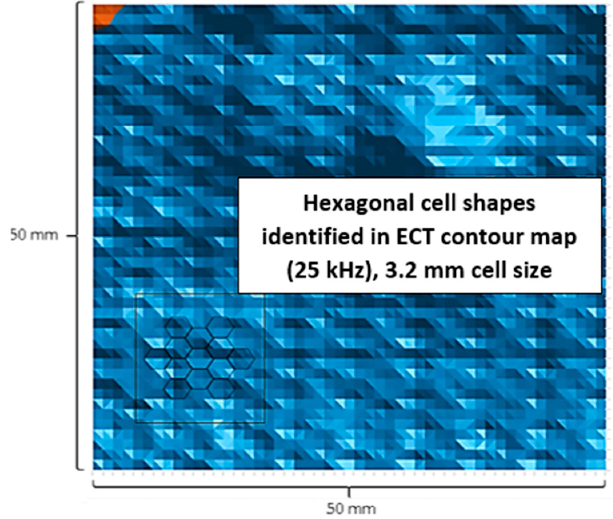
Figure 9. ECT core evaluation with identified cell geometries (25 kHz).